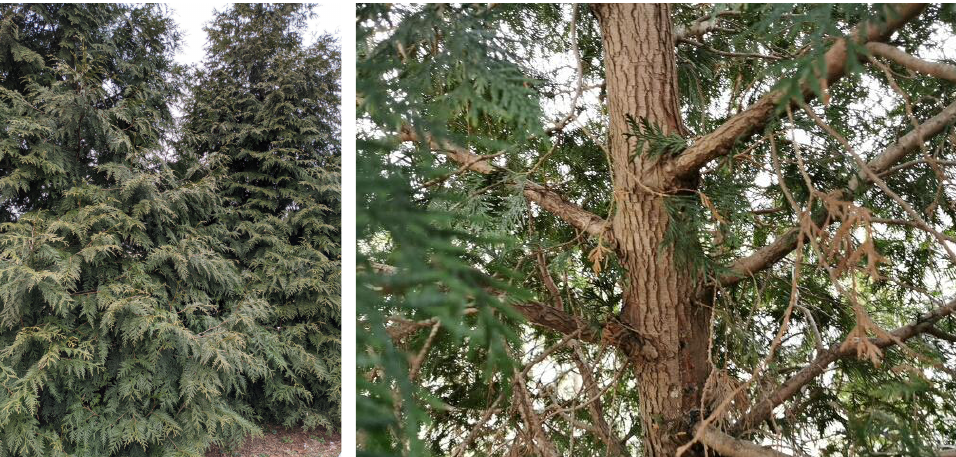
Figure 5. The designed app can estimate diameter without the surveyor touching the trunk, which speeds up measurement time for low-branching trees. Left , a small stand of cedars. Right , an image of the trunk taken by phone held just under the tree canopy.